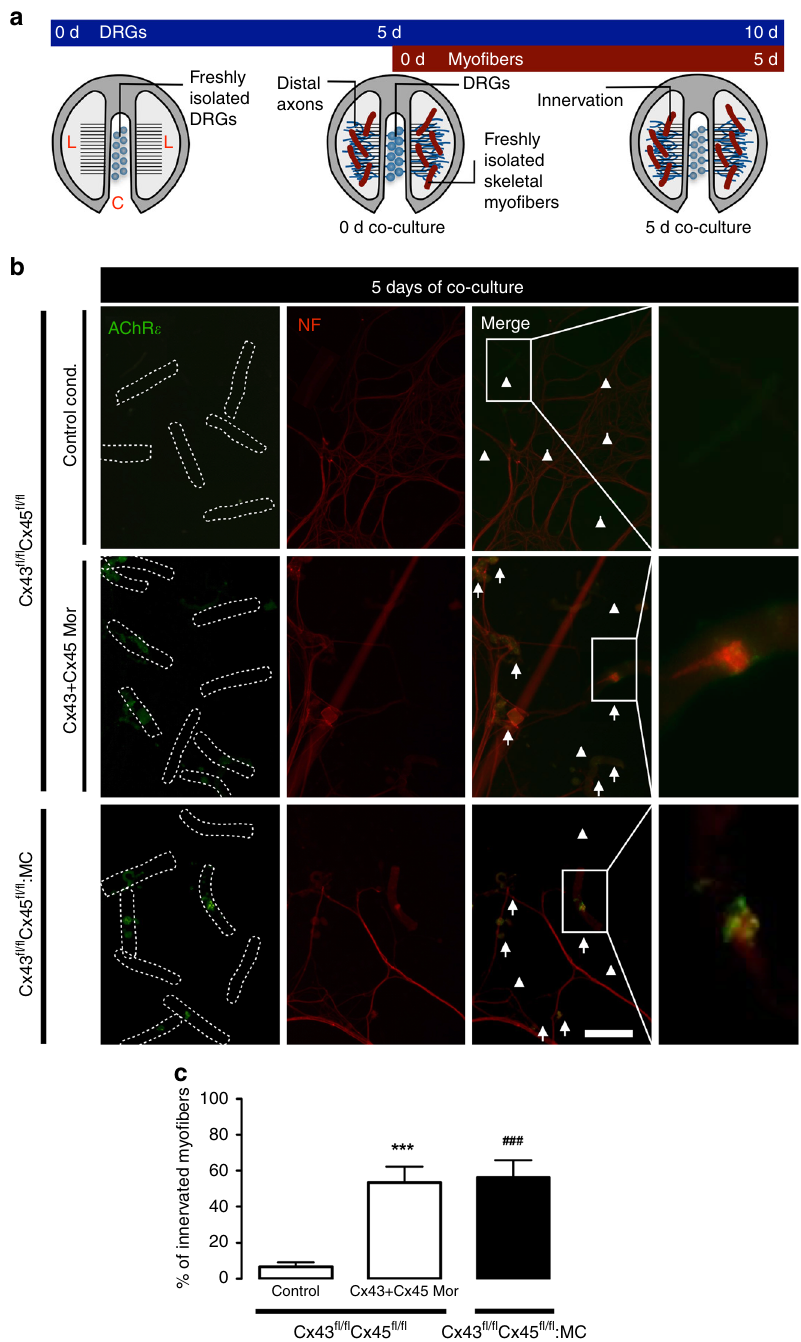
Fig. 6 The absence of Cx43 and Cx45 in cultured skeletal myo fi bers increases the percentage of innervation in co-culture. DRG explants were co- cultured with skeletal myo fi bers. a DRG explants were cultured in Campenot chambers in the central compartment (C), at 5 days of DRGs culture; skeletal myo fi bers are added in the lateral compartments (L) together with the distal axons (0 days of co-culture), up to 10 days of DRGs culture (5 days of co-culture). b Immuno fl uorescence of myo fi bers from Cx43 fl / fl Cx45 fl / fl mice under control conditions (Control cond.; top row), or treated with morpholinos to Cx43 and Cx45 (Cx43 + Cx45 Mor; middle row), and Cx43 fl / fl Cx45 fl / fl :MC mice (down row) at 5 days of co-culture of DRGs and myo fi bers, using antibodies against neuro fi lament 200 (NF; red; left column), and nicotinic acetylcholine receptor epsilon subunit (AChR ε ; green; middle left column). Merged images to identify innervated myo fi bers (middle right column). Arrows: innervated myo fi bers, arrowheads: non-innervated myo fi bers. Scale bar: 100 μ m. Dotted rectangle is the magni fi cation of innervated myo fi bers (right column). c Percentage of innervated myo fi bers. N = 5; at least 35 myo fi bers recorded in each independent experiment, each value is the mean ± SEM. The results obtained from Cx43 fl / fl Cx45 fl / fl mice are represented by white bars and from Cx43 fl / fl Cx45 fl / fl :MC mice by black bars. *** p < 0.001, for Cx43 + Cx45 Mor compared with Control cond. ### p < 0.001, for 43 fl / fl Cx45 fl / fl :MC compared with Control cond. by two-way ANOVA with Bonferroni post hoc